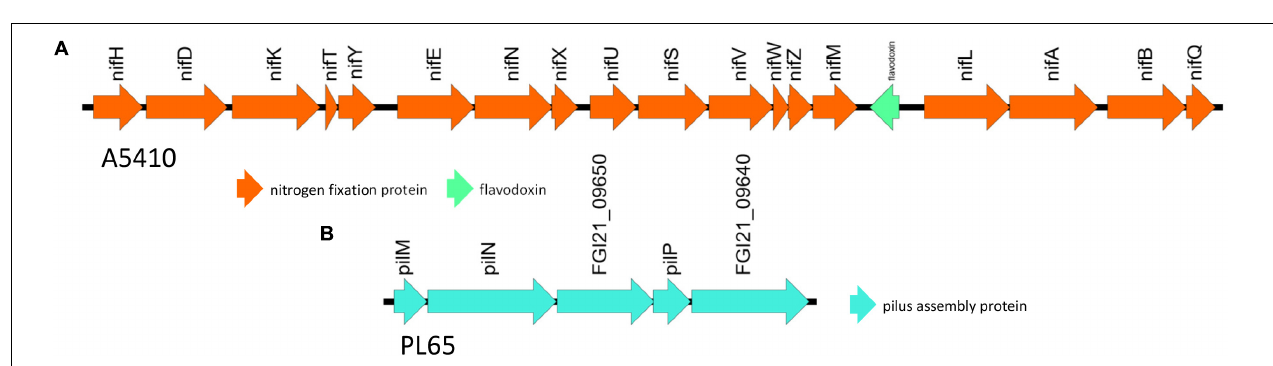
FIGURE 6 | Comparison of D. zeae genome sequences against each other. Venn diagram showing the number of clusters of orthologous genes, which are shared and unique at the strain level. Venn diagrams (A–E) are shown for the deduced proteins of A5410, PL65, Ech586, EC1, and MS2, respectively. Values were calculated by OrthoMCL clustering analyses using the following parameters: p -value cut-off = 1 × 10 − 5 ; identity cut-off = 90%; percent match cut-off = 80, deduced proteins of A5410, PL65, Ech586, EC1, and MS2, respectively. (F) The complete genome alignment of five linearized D. zeae genomes was performed using progressiveMAUVE. The scale represents the coordinates of each genome. Different color blocks represent local collinear blocks (LCBs), which are conserved segments in five genomes. Within LCBs, the white area represents low similarity regions or regions unique to one genome but absent in another. LCBs above the black horizontal central line are in forwarding orientation and below this are in reverse orientation. Colored lines show the rearrangement of LCBs among the genomes.